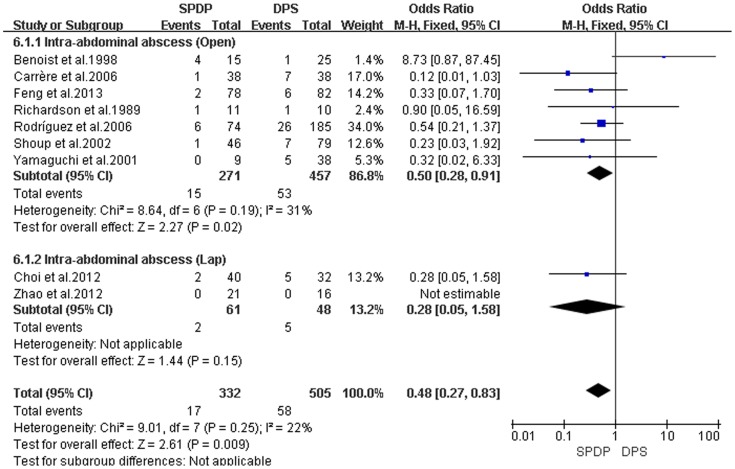
Intra-abdominal abscess (IV, Inverse variance; M-H, Mantel-Haenszel; CI, Confidence Interval; SD, standard deviation).